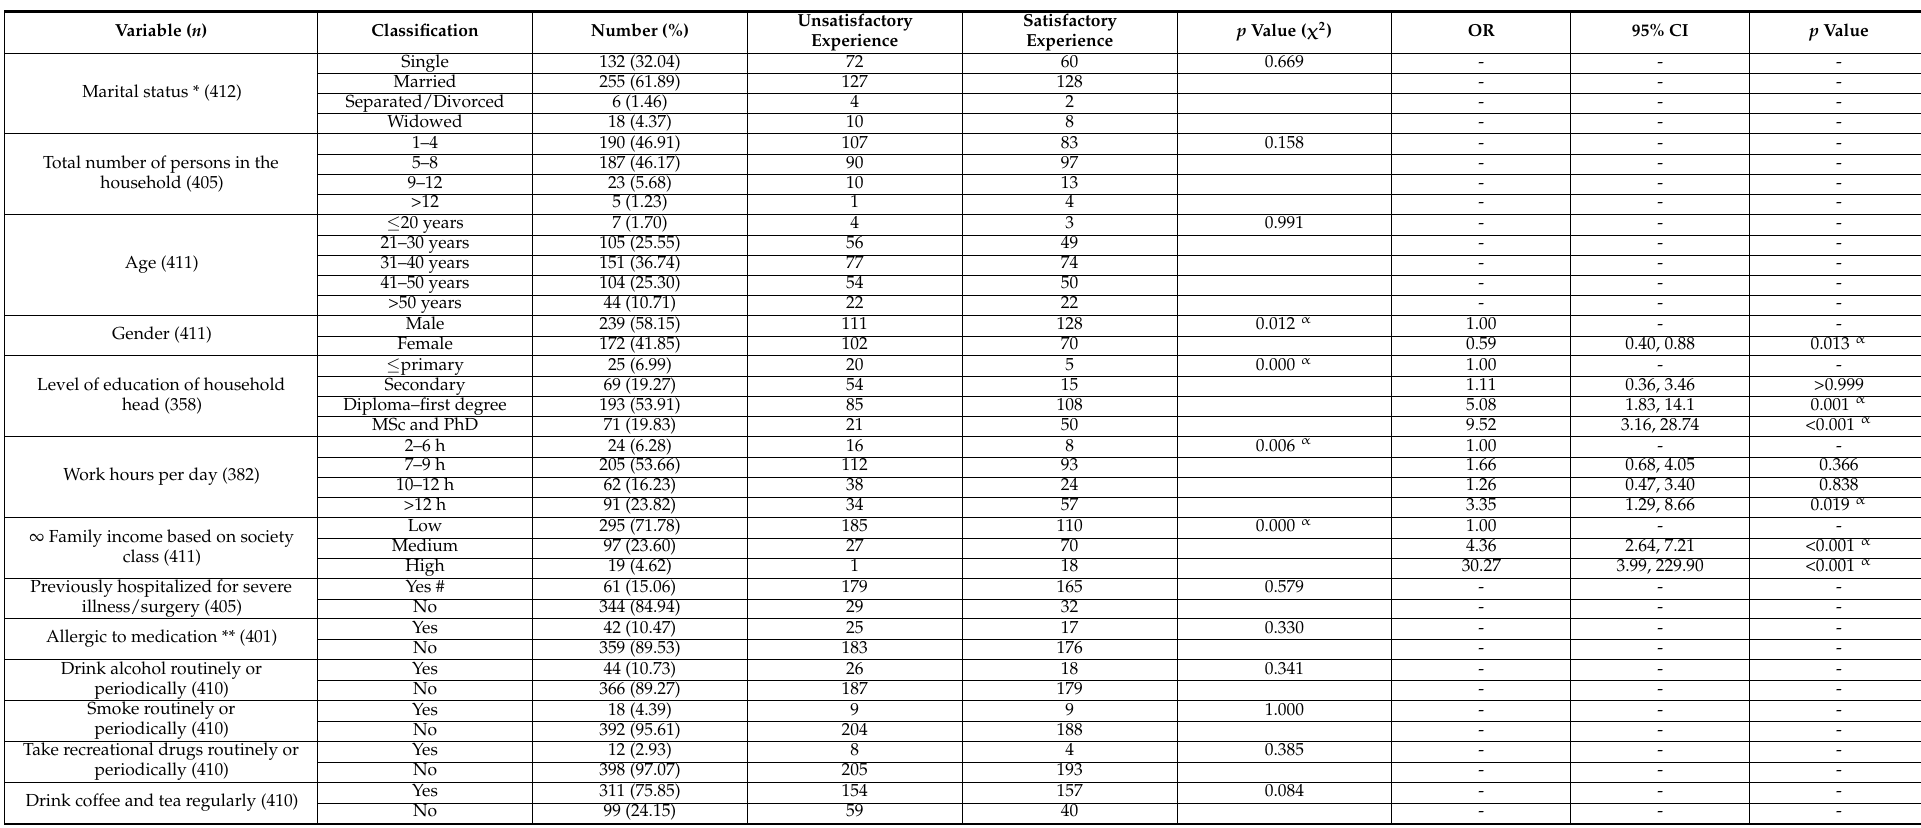
Table 2. Socio-demographic factors associated with food security and hunger experience of the respondents due to the impact of COVID-19 in